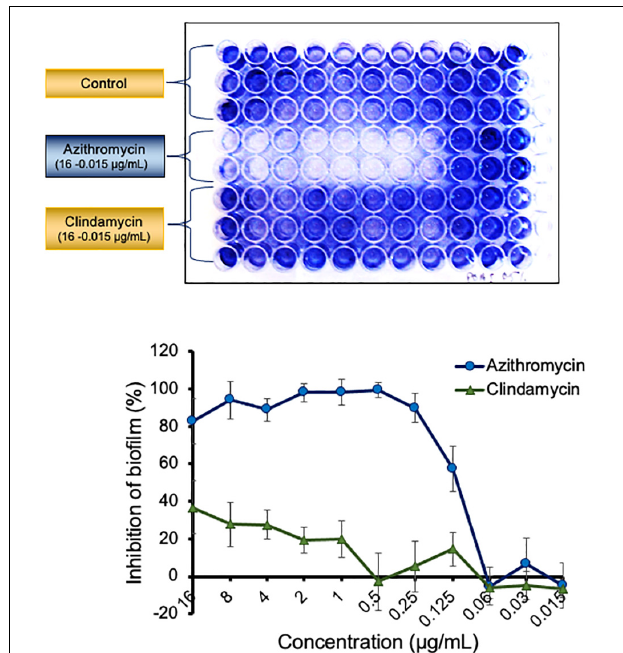
FIGURE 1 | Activity of azithromycin and clarithromycin against biofilm of P. aeruginosa PAO1 The adherent biofilm in presence of azithromycin, clindamycin or in control well (drug free) was stained with 1% crystal violet and measured by OD 600 after dissolving in 30% acetic acid. The inhibition of biofilm in presence of antibiotics was calculated by comparing the biofilm formation in control well. Values shown in the figure are average of three independent experiments.